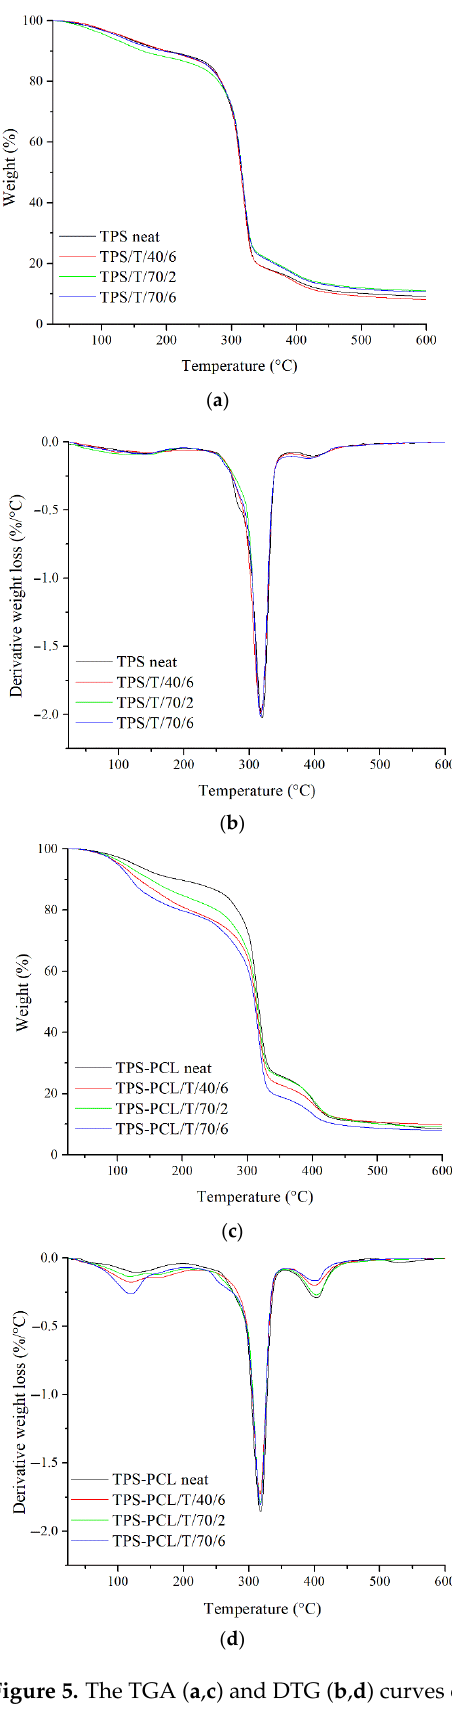
Figure 5. The TGA ( a , c ) and DTG ( b , d ) curves of neat and impregnated TPS and TPS–PCL samples.